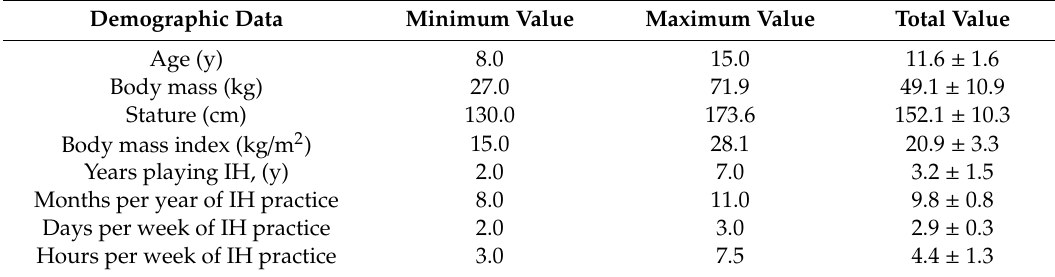
Table 1. Demographic data (mean ± standard deviation) for the youth competitive inline hockey players in this study ( n =